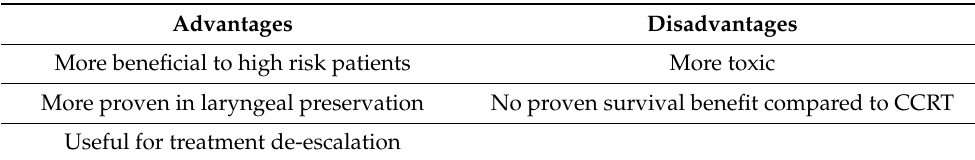
Table 3. Potential advantages and disadvantages of induction chemotherapy (IC) compared to concurrent chemoradiotherapy